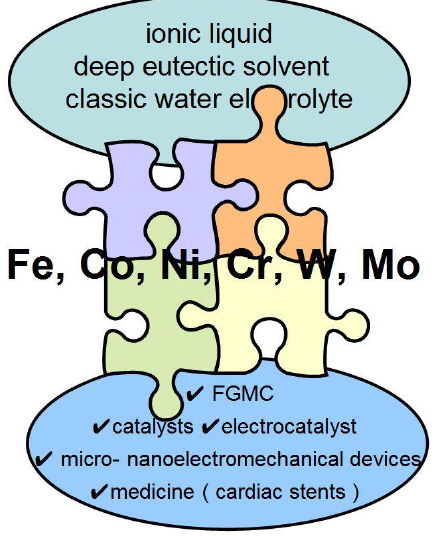
Figure 1. Bi- and ternary alloys of metals of the iron triad with chromium, molybdenum, and tung- sten.